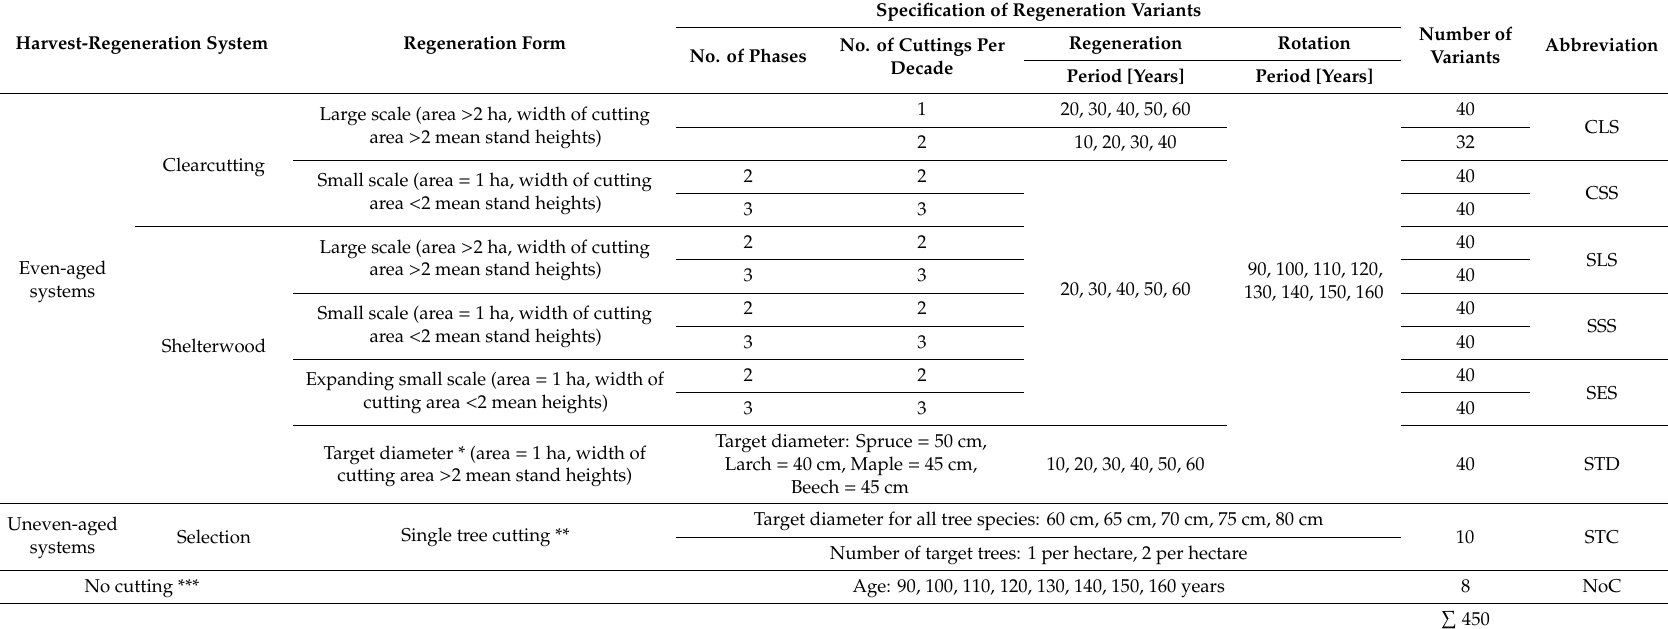
Table 2. Forms and variants of harvest regeneration systems considered in the